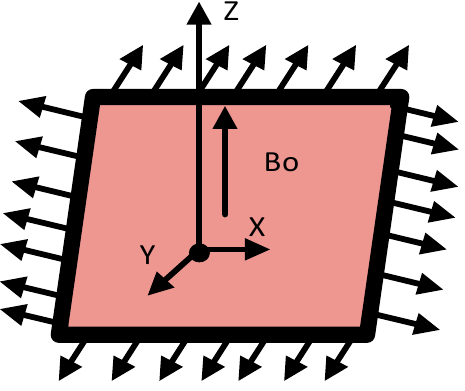
Figure 1. Flow Diagram.